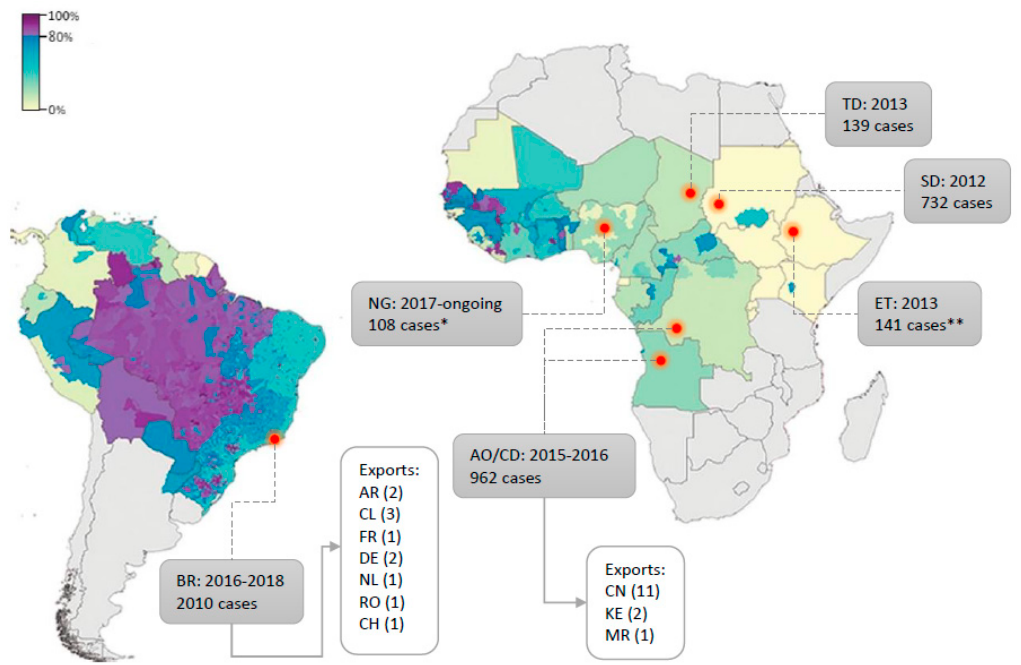
Figure 3. Yellow fever (YF) outbreaks since 2010 with regard to vaccination coverage at the time (modified from [299]). Estimated proportion of the population (across all ages, in %) to have ever received a YF vaccine at the beginning of 2010 for countries at risk of YFV transmission, based on the untargeted, unbiased vaccination-targeting scenario [299]. Countries where YFV outbreaks occurred since 2010 are indicated by a red dot. Outbreak time-span and total number of cases are detailed in grey boxes. Export cases are detailed when applicable. All country names’ abbreviations are defined according to international ISO country codes. * Presumptive positive cases ** reported